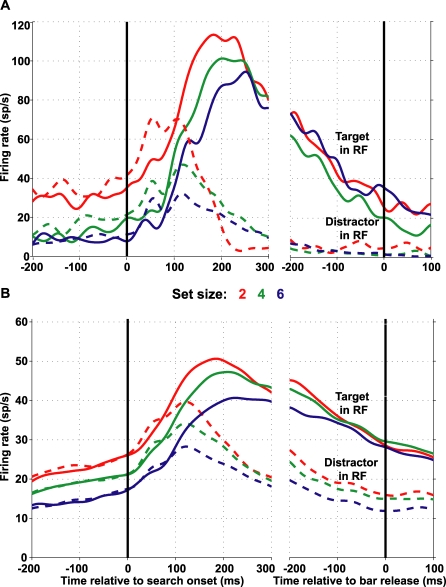
Set-Size Effect in LIP Neurons(A) Response of a representative neuron (neuron 12289), on trials in which the target (solid) or a distractor (dotted) were in the RF, at set-size 2 (red), 4 (green), and 6 (blue). Responses are aligned on search display onset (removal of line segments, time 0) in the left panel and on bar release in the right panel. For display purposes only, spike density histograms were derived by convolving individual spike times with a Gaussian kernel with a standard deviation of 15 ms. Standard error (computed every 1 ms and averaged across all conditions and time bins) was 2.69 spikes/s.(B) Average responses in the sample of neurons tested with all three set sizes (n = 50) using the same conventions as in (A). Average standard error was 2.73 spikes/s.